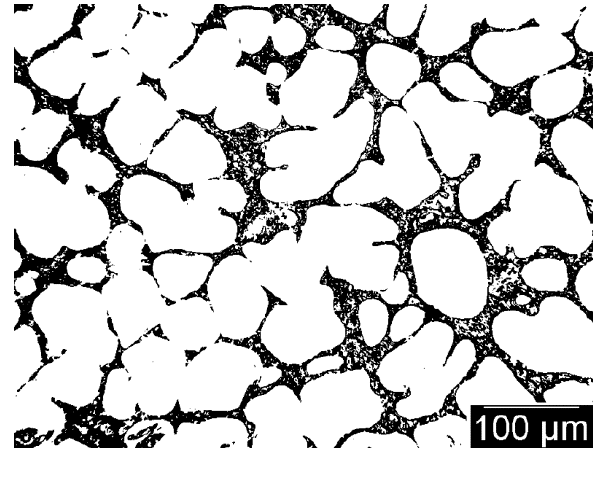
Figure 5. Binarized micrograph of Sample